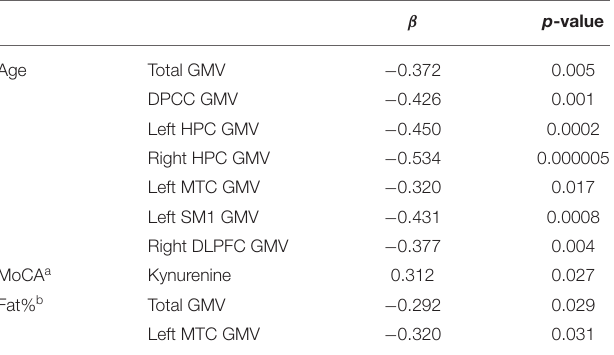
TABLE 4 | Effect of age, MoCA, and fat% on β p -value